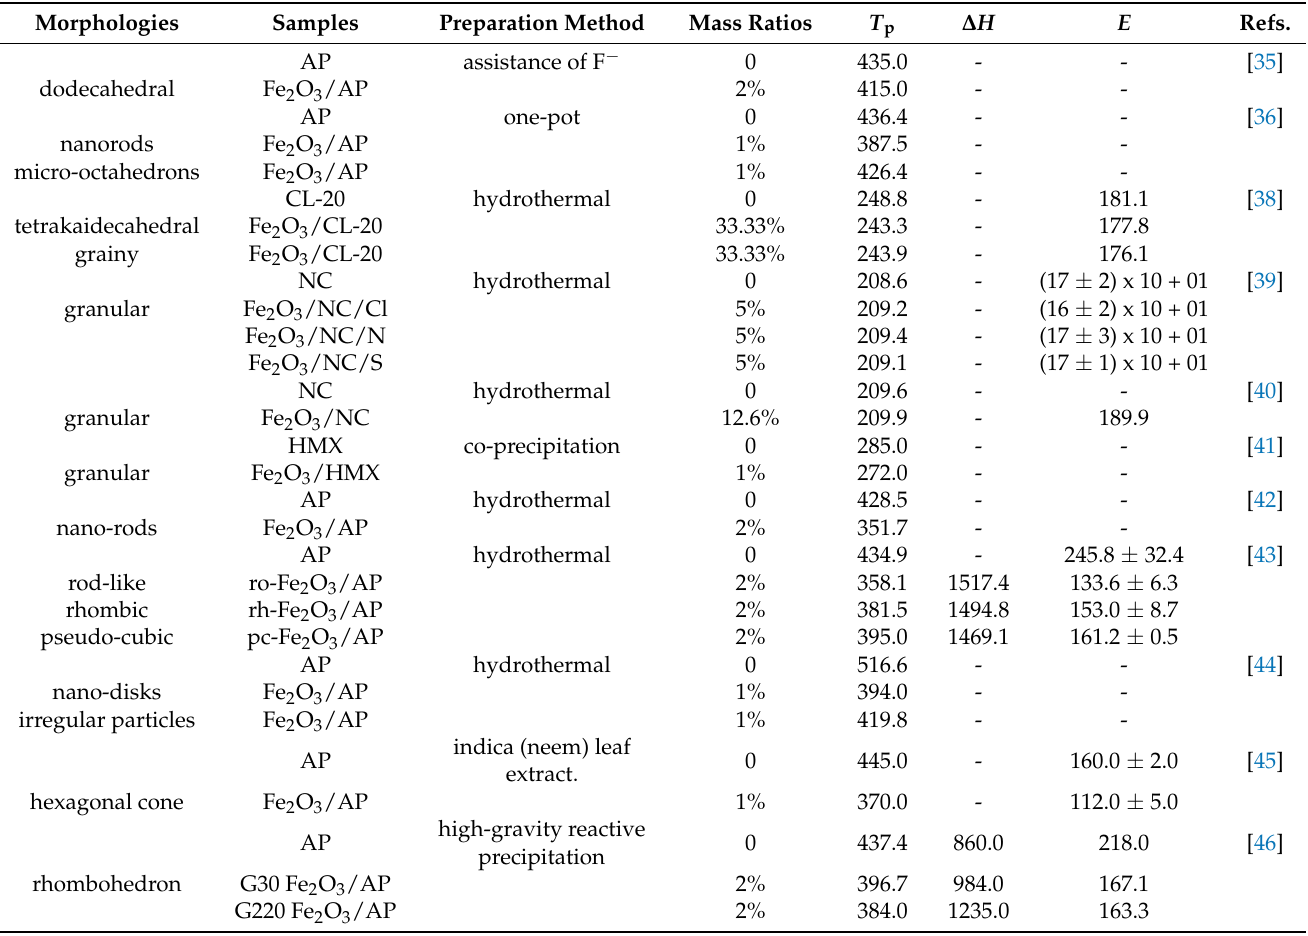
Table 1 summarizes the preparation methods, thermal decomposition temperature ( T p ), reaction heat ( ∆ H ), and apparent activation energy ( E ) of these hematite with energetic composites of different morphologies reported in recent years. The morphologies and particle sizes have a great influence on the thermal decomposition process of EMs. from the decrease in the decomposition temperature and activation energy. Table 1. Summary of thermal behavior parameters of EMs with different morphologies of